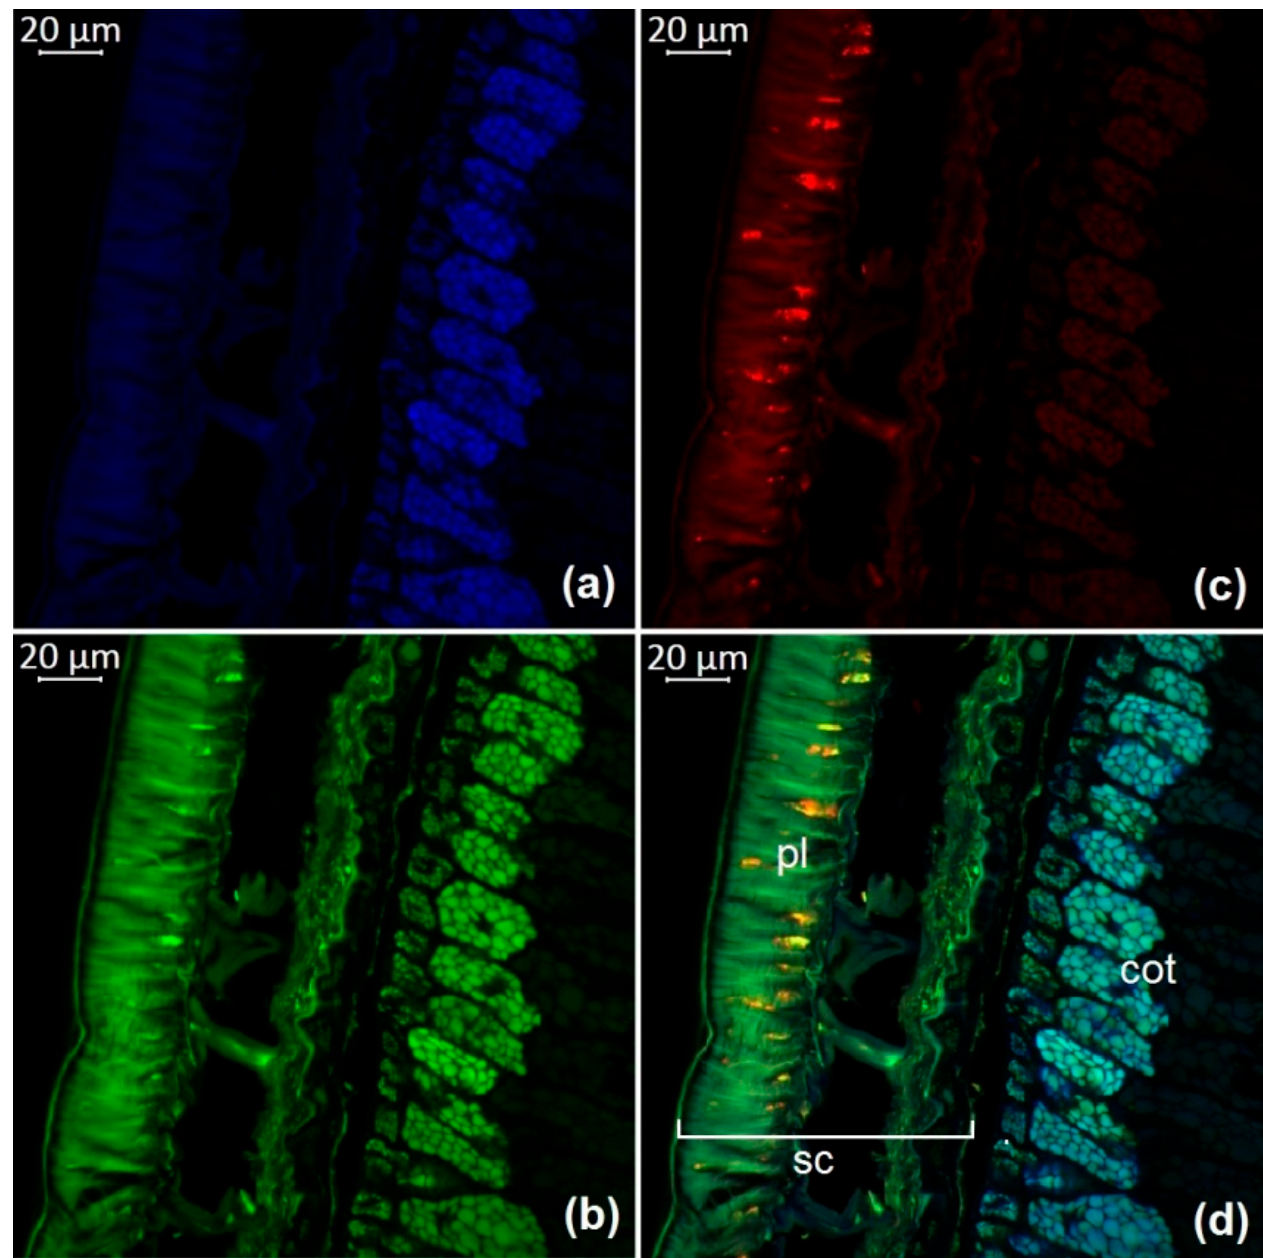
Figure 8. A transverse section of a soybean seed (variety Primorskaya-86): ( a ) excitation at 405 nm with emission in the range of 400–475 nm (blue); ( b ) excitation at 488 nm with emission in the range of 500–545 nm (green); ( c ) excitation at 488 nm with emission in the range of 620–700 nm (red); ( d ) merged; cot, cotyledon; pl, palisade layer; sc, seed coat.